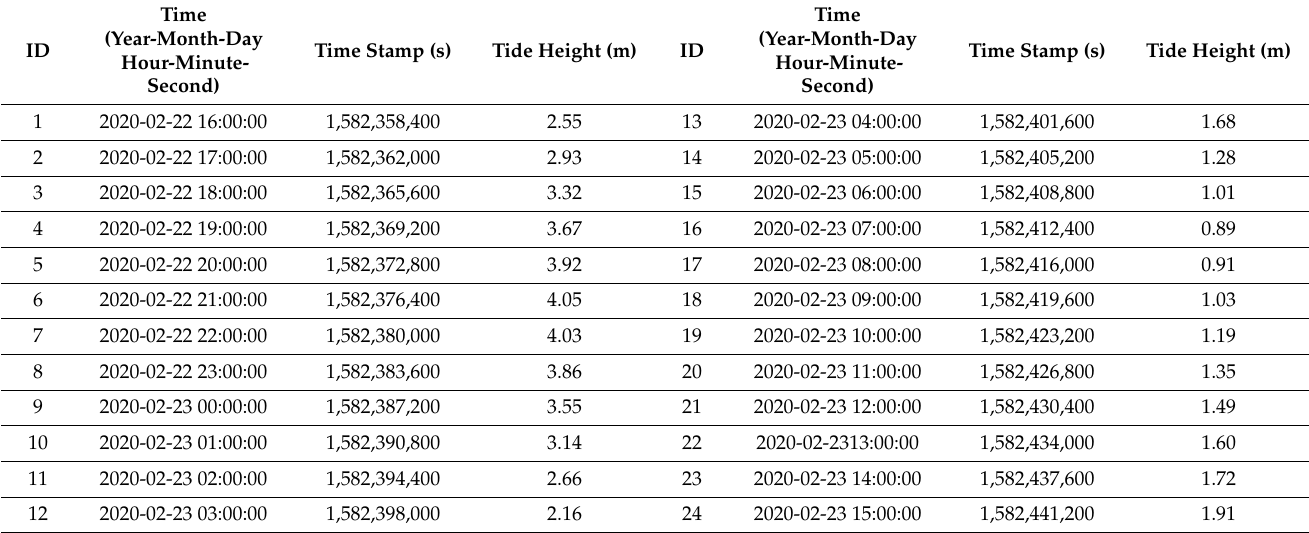
Table 1. The existing 24 tide height data, time, and corresponding time stamp (UTC Time).